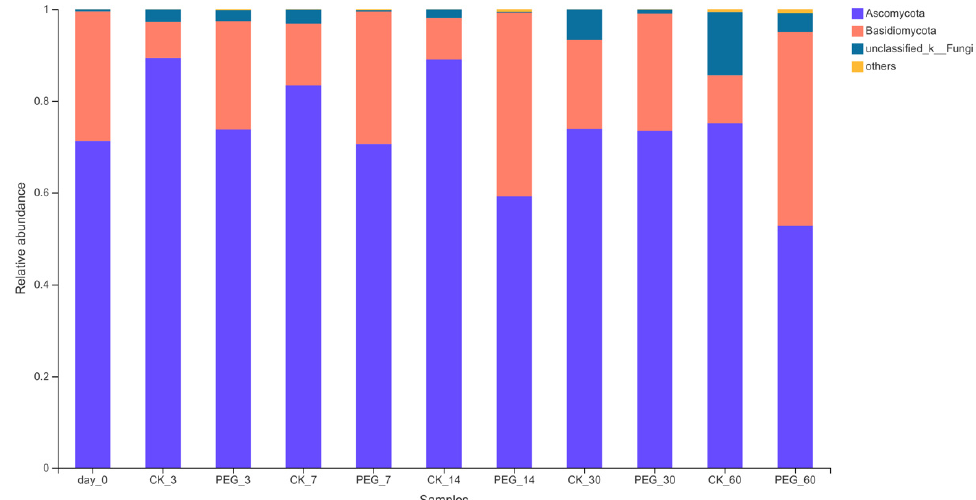
Figure 5. Relative abundance of fungi community on phylum level of PEG-treated and control group of sainfoin silage (CK_3: on day 3 of control ensiling; PEG_3: on day 3 of PEG-treated ensiling, same as others).